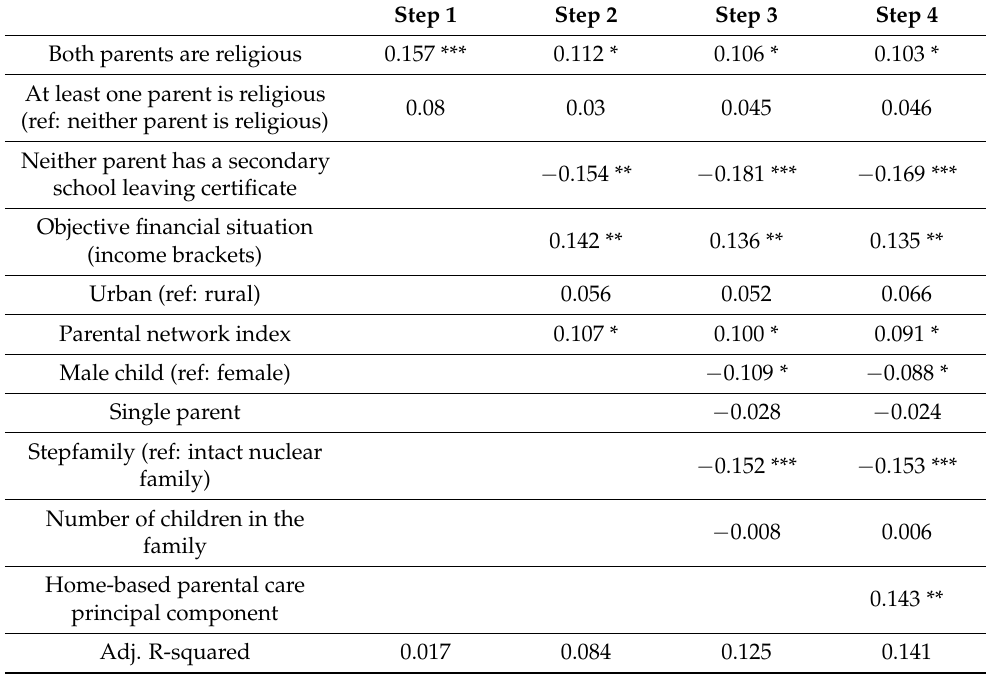
Table 2. Factors influencing the principal component of the effectiveness of parenting, multistage linear regression results (regression betas and the significance level of